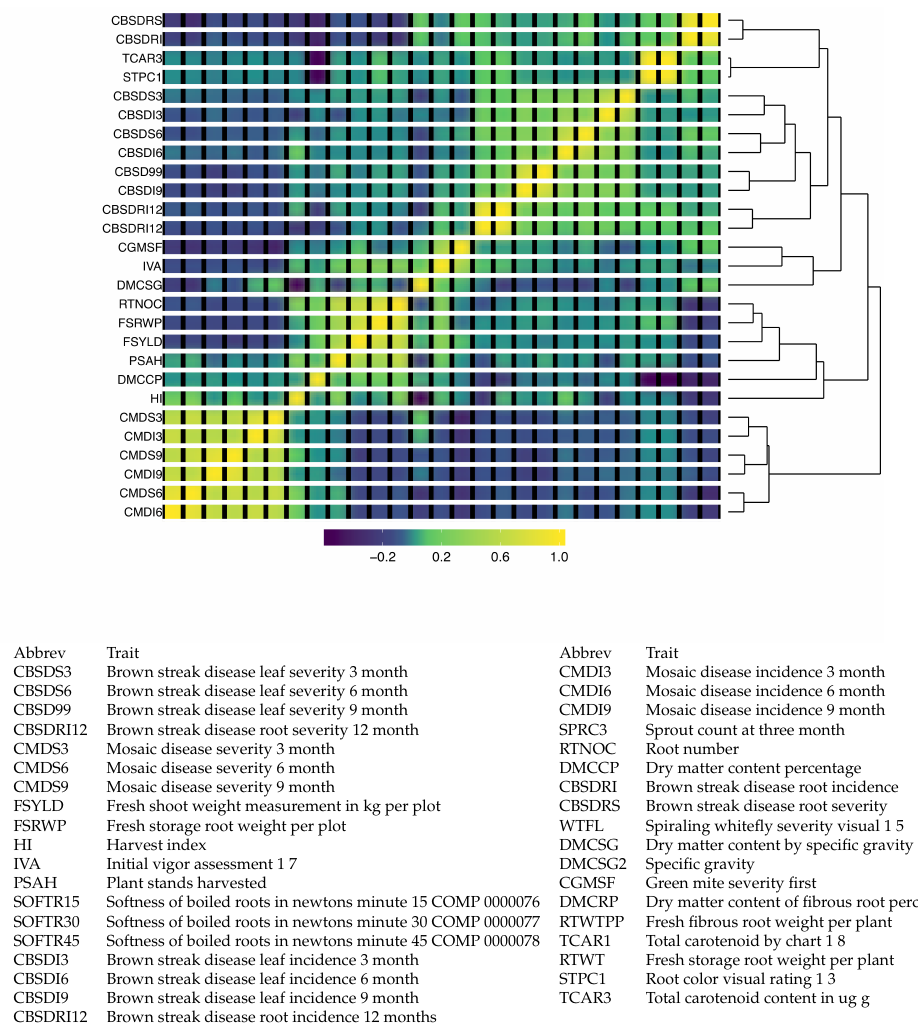
Figure 5. Illustration 4—Cassava data: The resulting combined covariance matrix for 37 traits obtained by combining the sample covariance matrices from 50 phenotypic trials downloaded from CassavaBase. Abbrev: